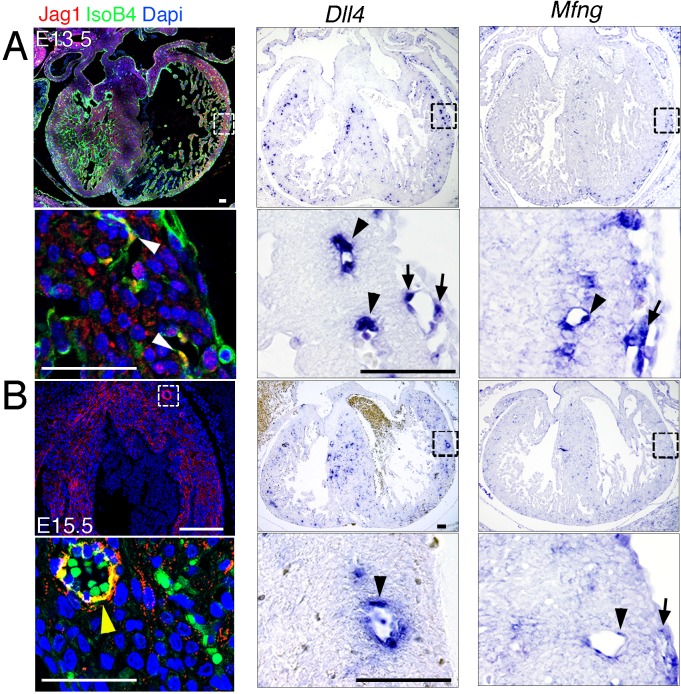
Jag1, Dll4, and Mfng expression in developing coronary vessels.(A) E13.5 control heart. Left, immunohistochemistry for Jag1 (red) and IsoB4 (green); the magnified view shows co-staining of Jag1 and IsoB4 in coronary arteries (white arrowheads). Center and right, ISH for Dll4 and Mfng; magnified views show expression in coronary arteries (black arrowheads) and sub-epicardial vein (arrows). (B) E15.5 control heart. Immunohistochemistry for Jag1 (red) and IsoB4 co-staining (green); the magnified view shows co-staining of Jag1 and IsoB4 in a coronary artery (yellow arrowhead). Dapi counterstain (blue). ISH for Dll4 and Mfng expression; magnified views show expression in a coronary artery (black arrowheads) and sub-epicardial vein (arrow). Scale bars, 50 μm. Images for Jag1 immunostainings were acquired on Nikon A1-R microscope. Software: NIS Elements AR 4.30.02. Build 1053 LO, 64 bits. Objectives: Plan Apo VC 20x/0,75 DIC N2 dry; Plan Fluor 40x/1,3 Oil DIC H N2 Oil.